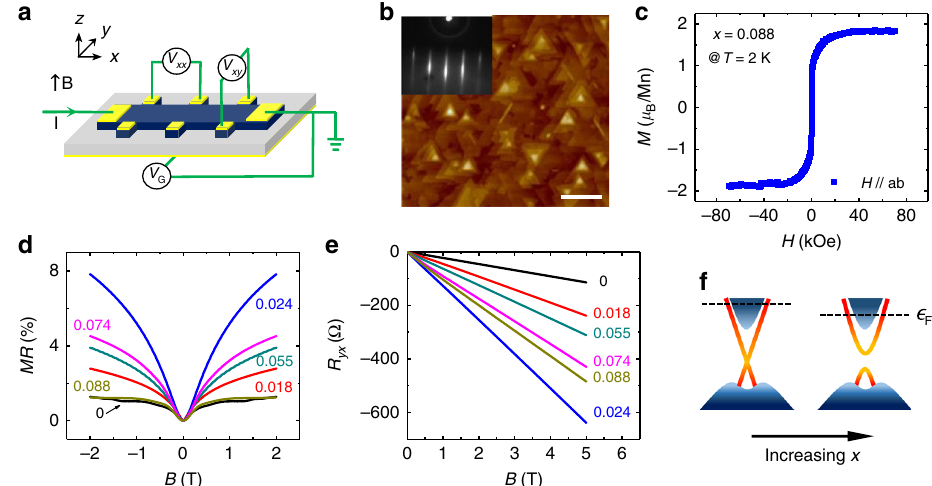
Fig. 1 Basic characterization of (Bi 1 − x Mn x ) 2 Se 3 fi lms. a Sketch of a back-gated Hall bar device used in the electron transport measurements. b Atomic force microscopy (AFM) and in situ re fl ection high-energy electron diffraction (RHEED) (inset) images of a 10 quintuple-layer (QL) thick (Bi 1 − x Mn x ) 2 Se 3 fi lm ( x = 0.02) grown on a STO(111) substrate. c In-plane magnetization as a function of applied magnetic fi eld for a 70 nm thick (Bi fi lm with x = 1 − x Mn x ) 2 Se 3 0.088 at T = 1.6 K. The inset shows the temperature dependence of in-plane magnetization. A linear background is subtracted to account for the paramagnetic signal from the STO substrate. Detailed discussion of the magnetic order in the (Bi,Mn) 2 Se 3 thin fi lms is given in Supplementary Note 3. d , e Magnetoresistance (MR) and Hall resistance R yx at x = 0, 0.018, 0.0244, 0.055, 0.074, and 0.088 at T = 1.6 K. The MR is de fi ned as [ R xx ( B ) − R xx (0)]/ R fi lms without (left) and with (right) the surface energy gap induced by the Mn xx (0). f Schematic sketch of band diagrams of the (Bi,Mn) 2 Se 3 thin